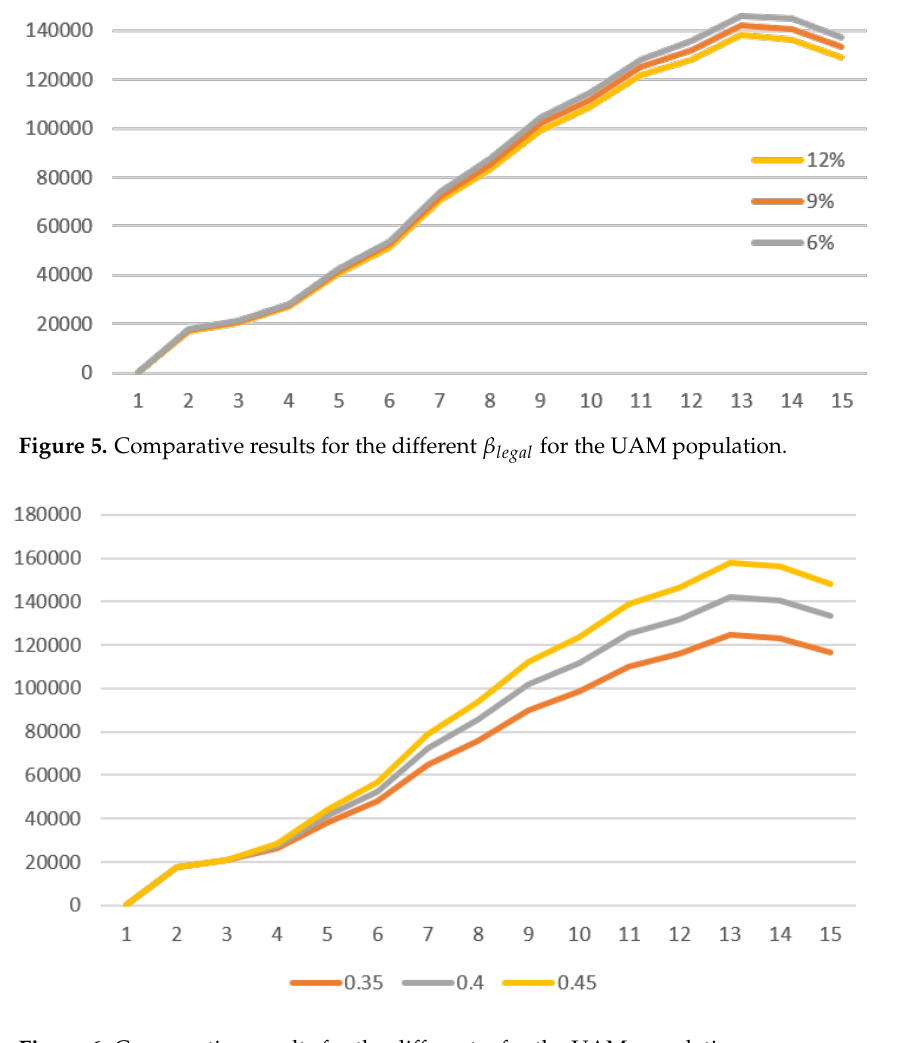
Figure 6. Comparative results for the different α for the UAM